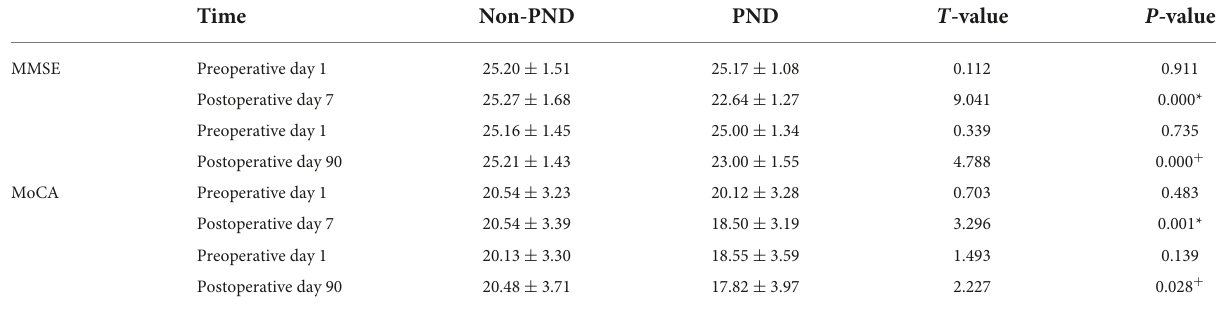
TABLE 2 Neuropsychological test results for patients with/without PND.